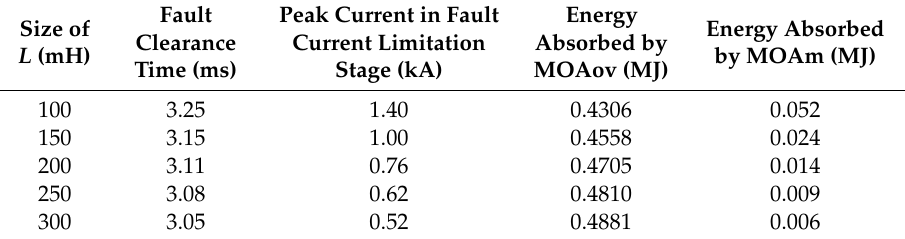
Table 1. Repressing the statistical details of system response under varying values of L .